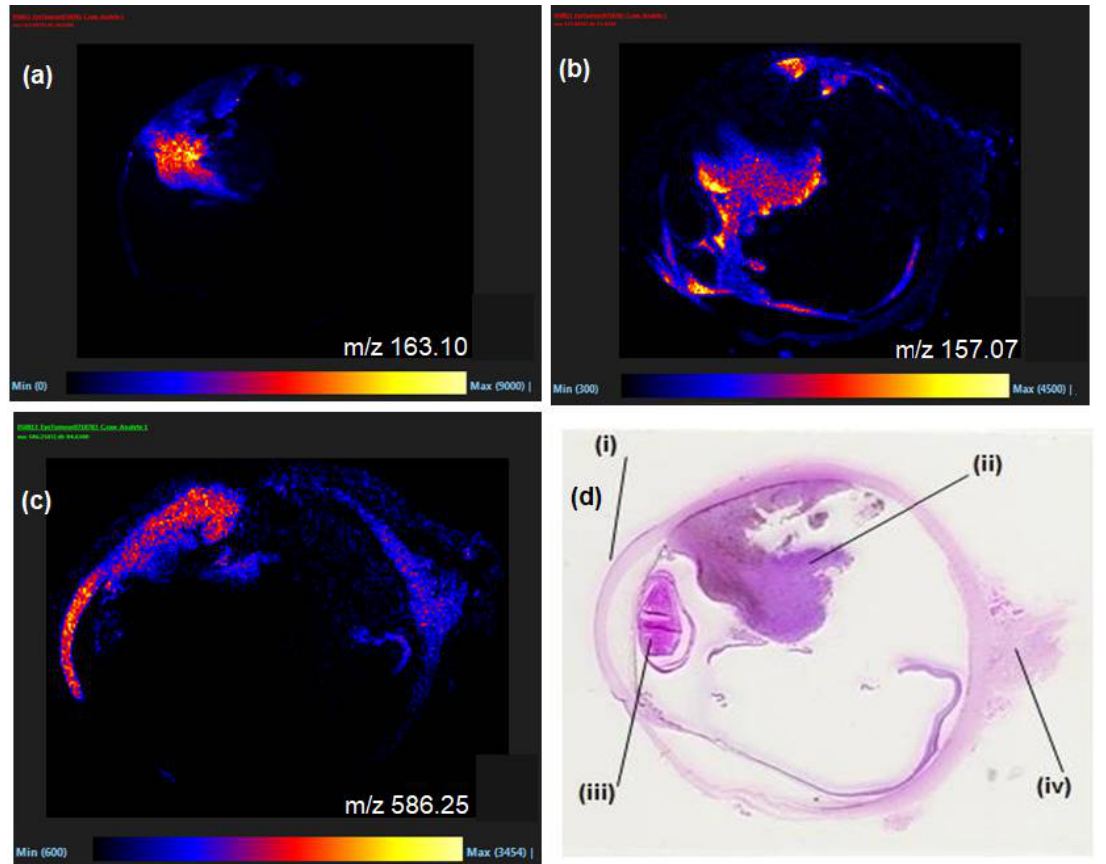
Figure 1. ( a – c ) Selected MALDI-MSI images of a FFPE section of human eye exhibiting UM with spatial distribution of m/z 586.2, [M + K] + , LPC 20:2 in ( c ), ( d ) H&E stained sectioned with (i) cornea, (ii) UM tumour regions, (iii) lens and (iv) optic nerve regions labelled.